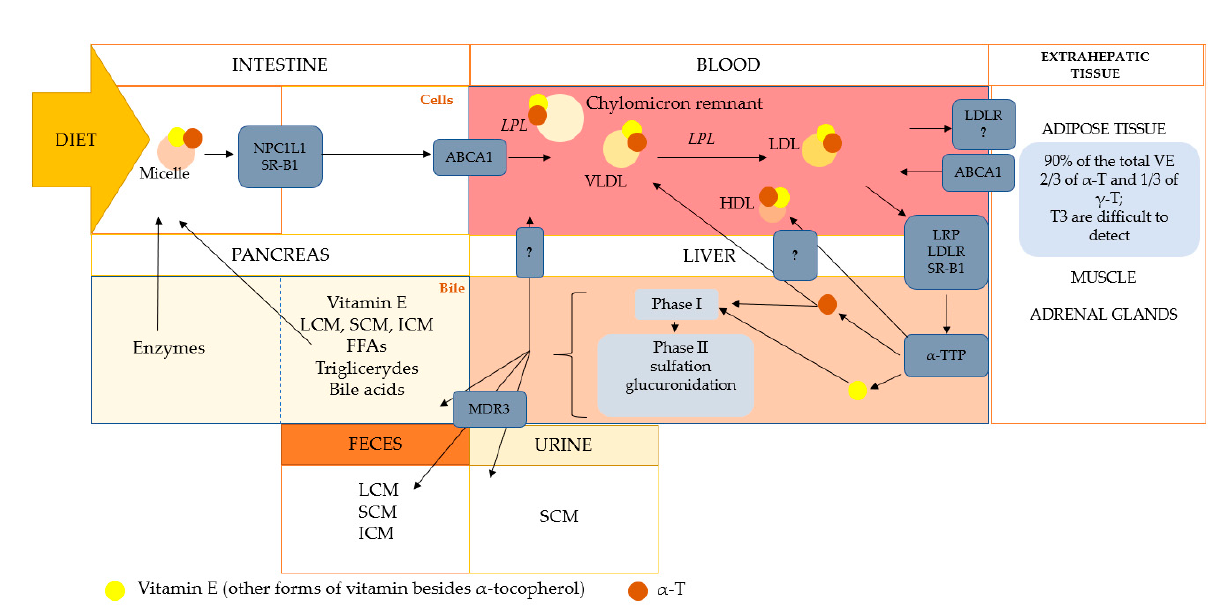
Figure 2. The simplified scheme of the transport and metabolism of vitamin E. The metabolism of vitamin E follows generally like other lipids species. In the intestine, vitamin E, along with other lipids, is packed into micelles, which are captured by receptors. In the intestinal epithelial cells, vitamin E is incorporated into chylomicrons or HDL via ABCA1. Vitamin E in the blood follows the lipoprotein transport route and is delivered to the liver or extrahepatic tissues. Vitamin E transport takes place with the participation of chylomicrons, which are subjected to hydrolysis by lipoprotein lipase. Further transport of vitamin E is through by chylomicron remnants, HDL, LDL, and VLDL. In the liver, vitamin E is sorted and directed to catabolism or to various lipoproteins (the mechanisms are not fully understood), returning to the bloodstream. The transport route is the same for all forms of vitamin E. Discrimination of the other forms in favor of α -tocopherol occurs in the liver by α -TTP, which protects against excessive degradation and excretion of α -tocopherol. The remaining forms of vitamin E are included in catabolism (phase I and II). NPC1L1, Niemann-Pick C1 Like 1 protein; SR-B1, scavenger receptor class B type 1; ABCA1, ATP-binding cassette transporter; VLDL, very-low-density lipoproteins; HDL, high-density lipoproteins; LDL, low-density lipoproteins; LDLR, LDL receptor; VE, vitamin E; α -T, alpha-tocopherol; γ -T, gamma-tocopherol; T3, tocotrienols; LRP, LDL receptor-related protein; LCM, long-chain metabolites (13 (cid:48) -COOH); ICM, intermediate-chain metabolites (11 (cid:48) -COOH, 9 (cid:48) -COOH); SCM, short-chain metabolites (7 (cid:48) -COOH, 5 (cid:48) -COOH, 3 (cid:48) -COOH); FFAs, free fatty acids; MDR3, multidrug resistance protein 3. The figure was modified from [1,32–36]. The uptake of different forms of vitamin E into the liver is probably